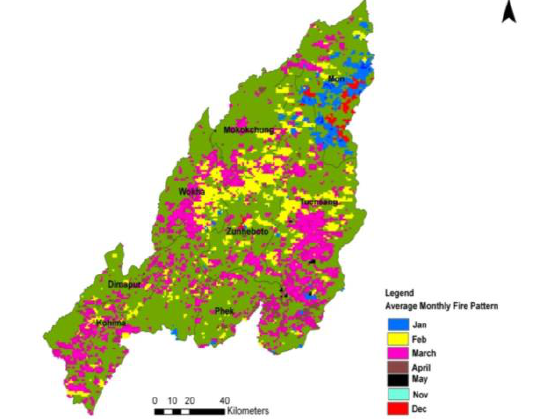
Fig. 3. Spatial distribution of monthly forest fires in Nagaland (2001-2013).